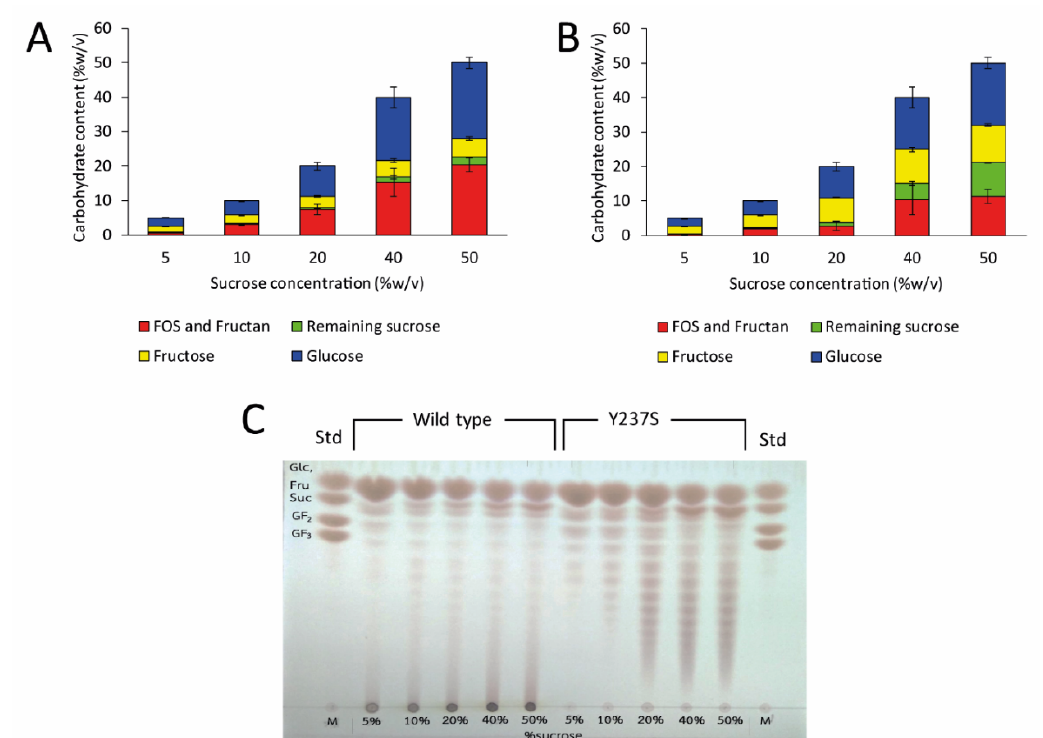
Figure 8. Effect of sucrose concentration on LFOS product. The amount of fructose, glucose, remaining sucrose and transglycosylated products produced by ( A ) wild-type and ( B ) Y237S variant LsKK9 was analyzed by HPLC. ( C ) LFOS profiles were analyzed by TLC.